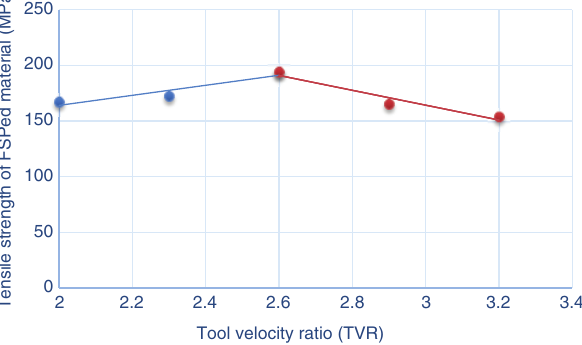
Figure 9: Effect of TVR on tensile strength of FSPed